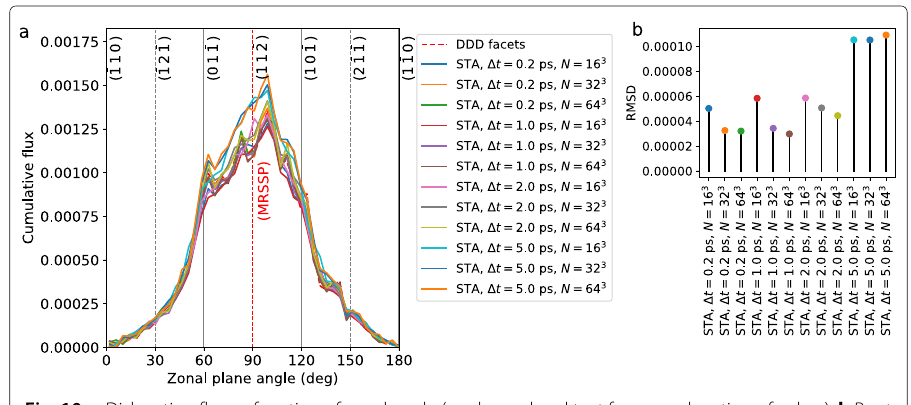
Fig. 10 a Dislocation flux as function of zonal angle (see legend and text for an explanation of colors). b Root mean square deviation (RMSD) from the “true” DDD flux of the zonal flux computed from STA facets using different STA parameters